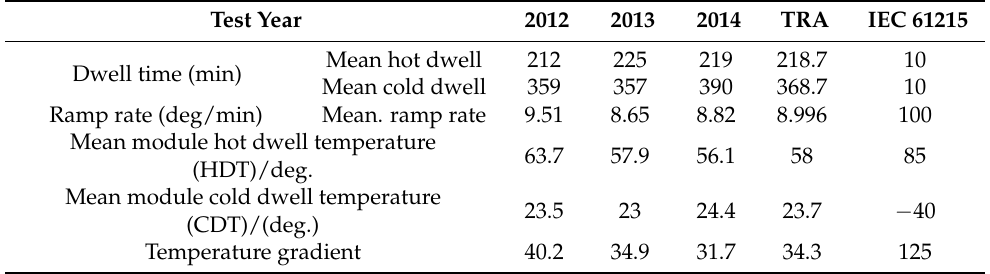
Table 1. Thermal loads and boundary conditions from field thermal cycling [20].